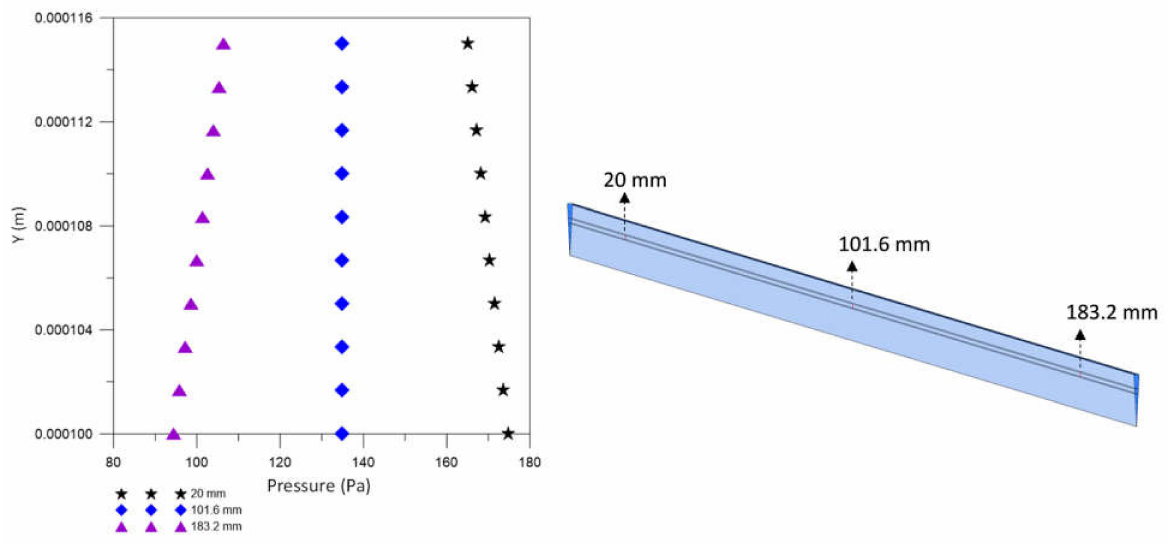
Figure 17. Pressure profile inside the membrane, in the axial positions of 20.0 mm, 101.6 mm, and 183.2 mm, at t = 6200 s (Case 9).